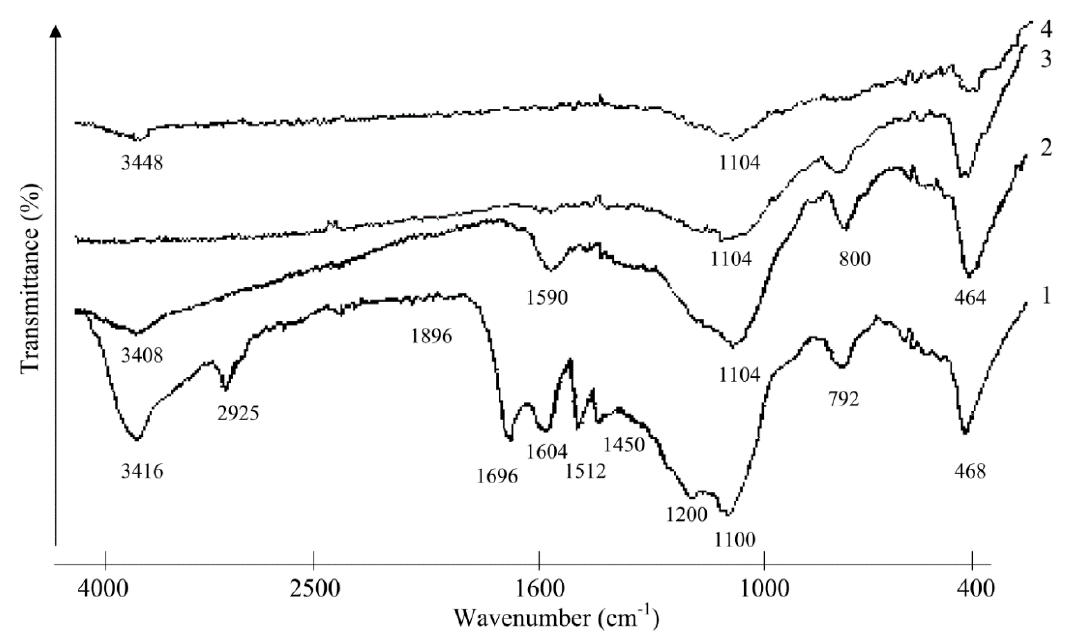
Figure 1. IR spectra of hydrolytic lignin and its carbonization products: 1—L (3 mg); 2—L-500 (3 mg); 3—L-650 (3 mg); 4—L-800 (1 mg).